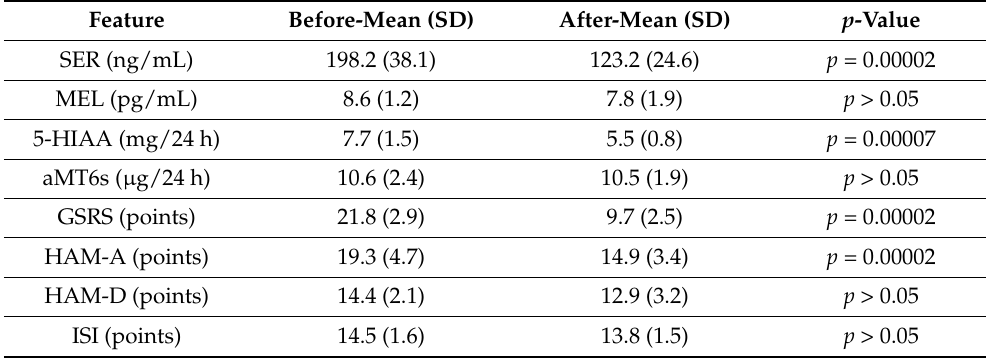
Table 4. Compounds of the serotonin pathway and severity symptoms in patients with IBS-D before and after nutritional